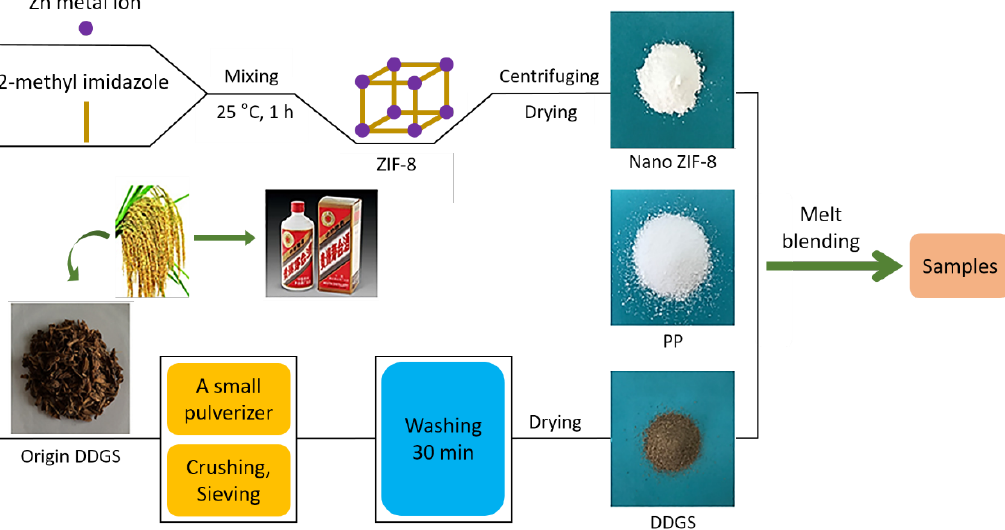
Figure 35. Preparation routes of polypropylene (PP) composites. Reprinted with permission from Ref. [238]. Copyright 2012, John Wiley & Sons, Ltd.